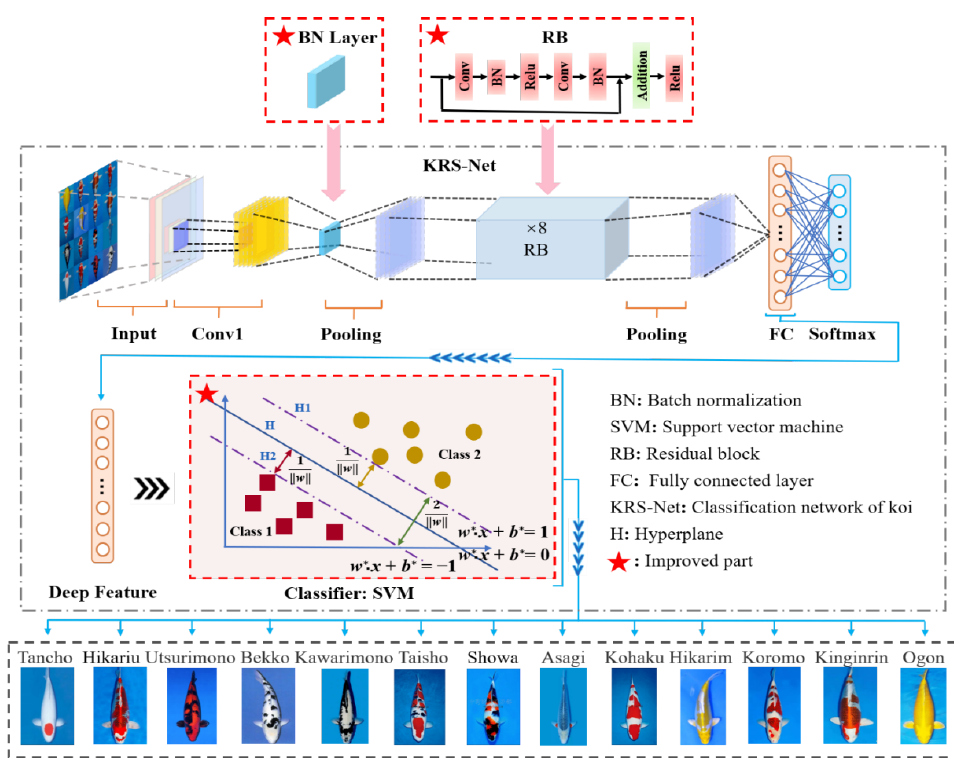
Figure 3. Schematic diagram of the proposed KRS-Net.